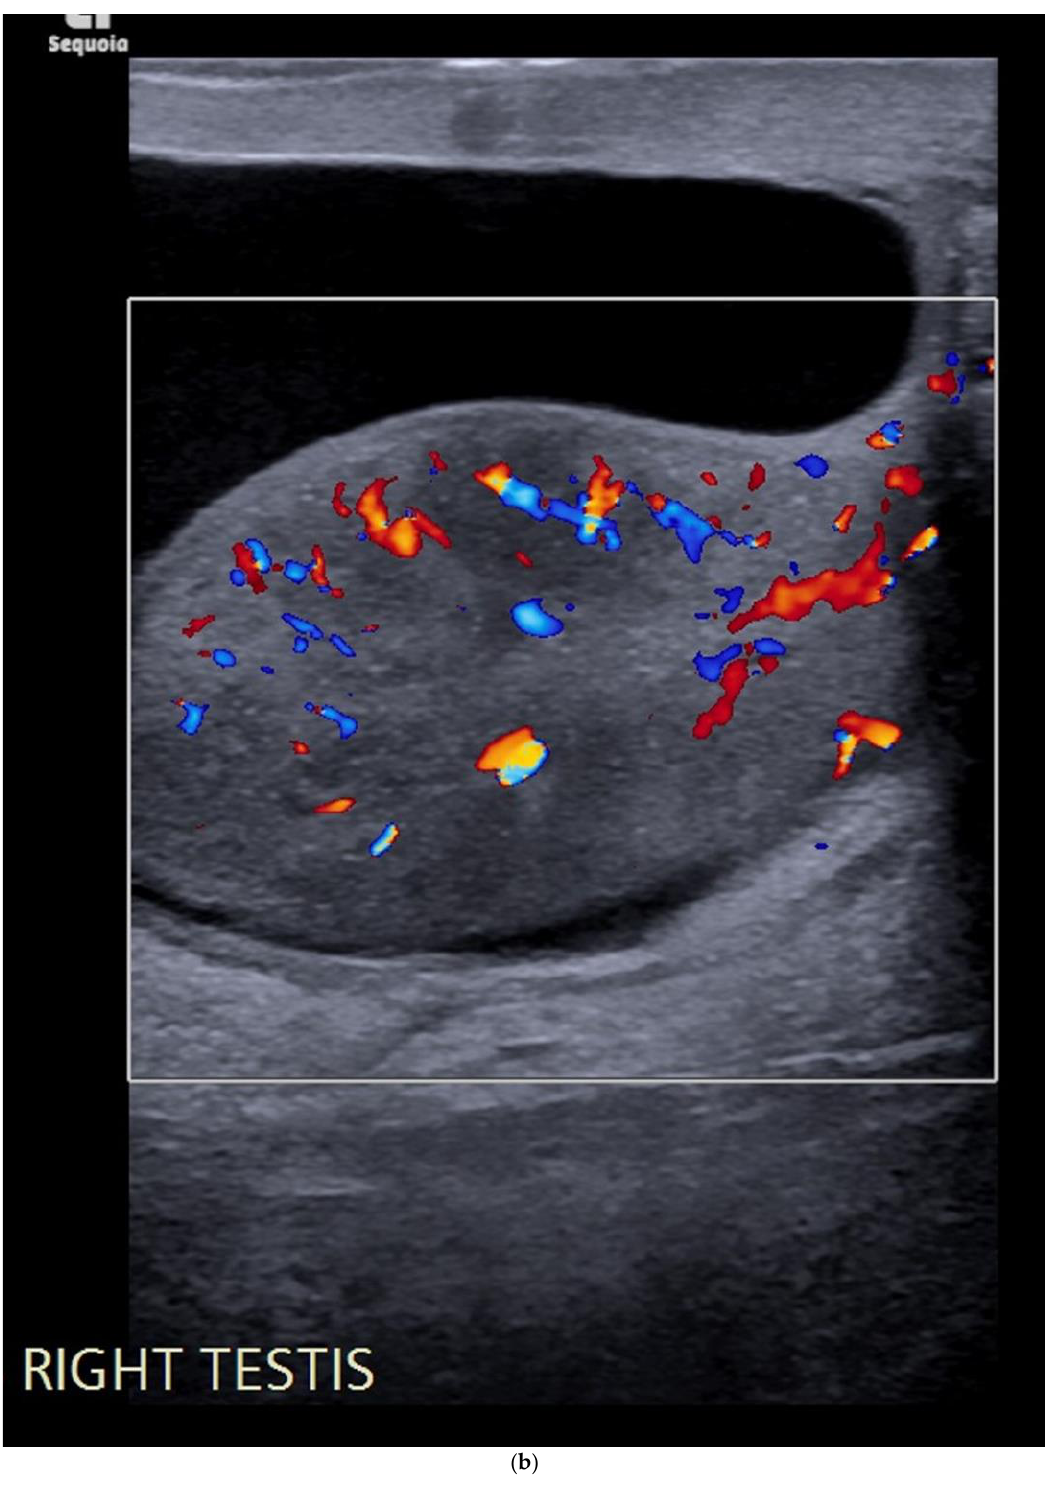
Figure 6. ( a ) B-mode ultrasound shows an enlarged, heterogeneous testis with a hydrocele. The epi-didymis was also enlarged, in keeping with epididymo-orchitis, but can be a tumour mimic. ( b ) Colour Doppler shows increased vascularity throughout the testis.